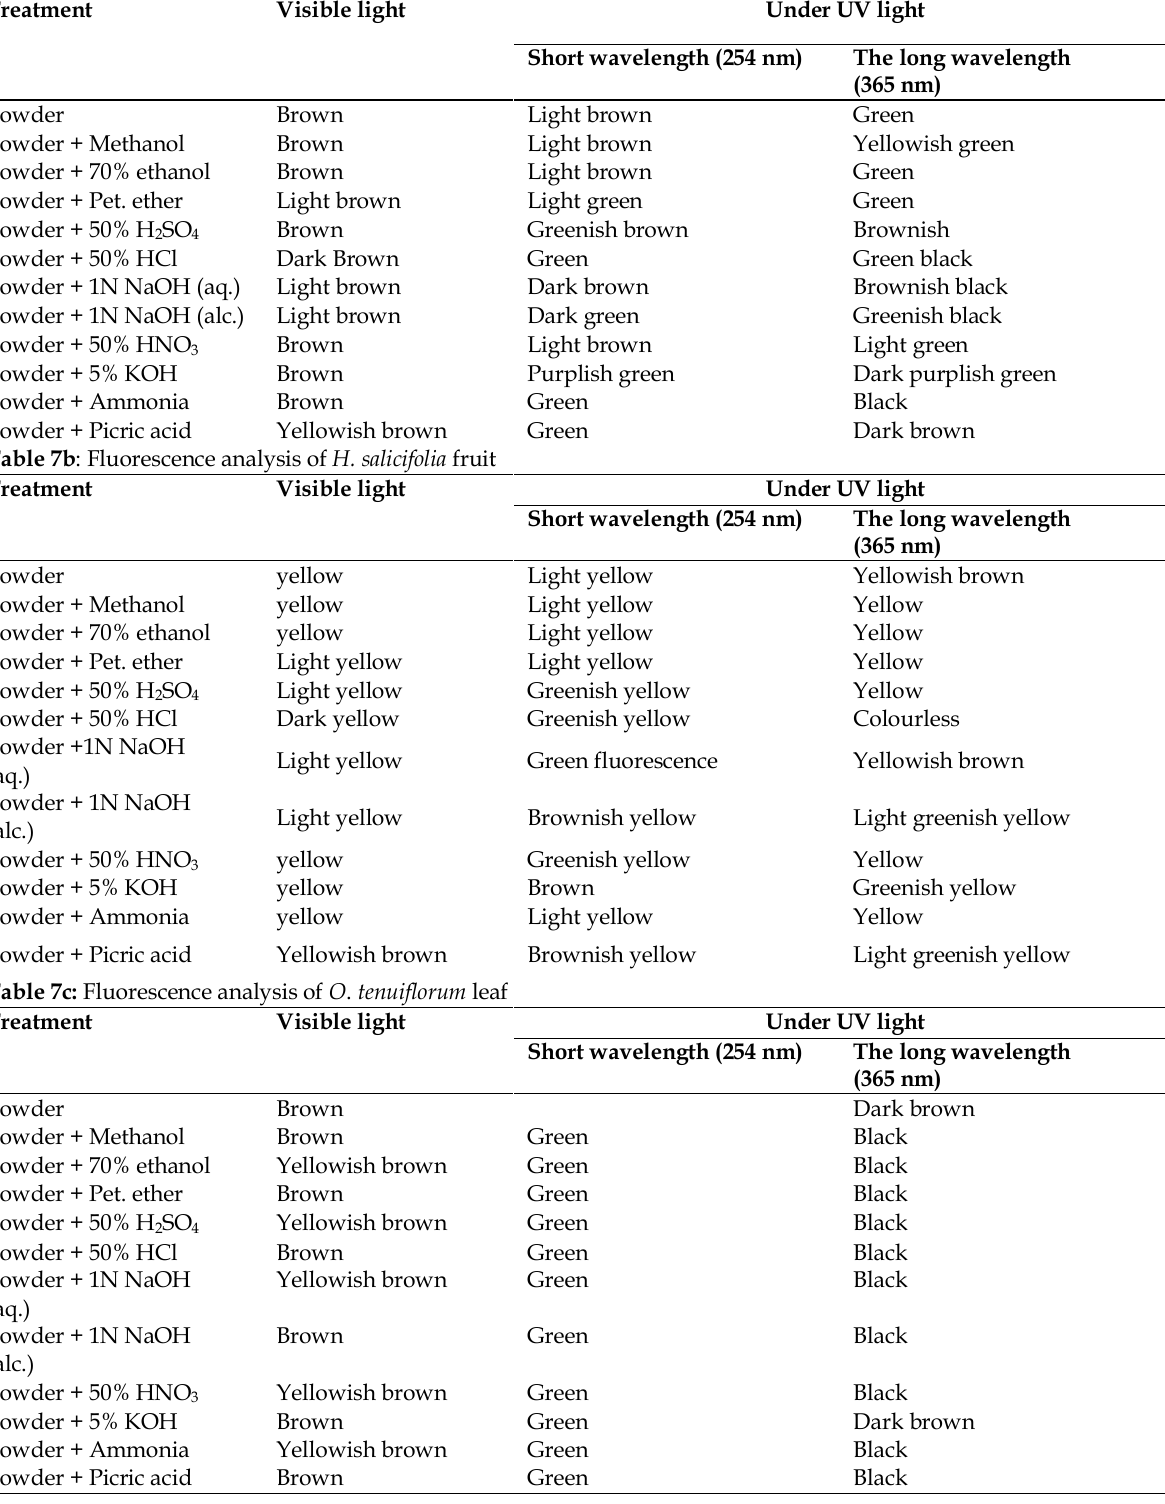
Table 7a : Fluorescence analysis of N. arbor-tristis leaf